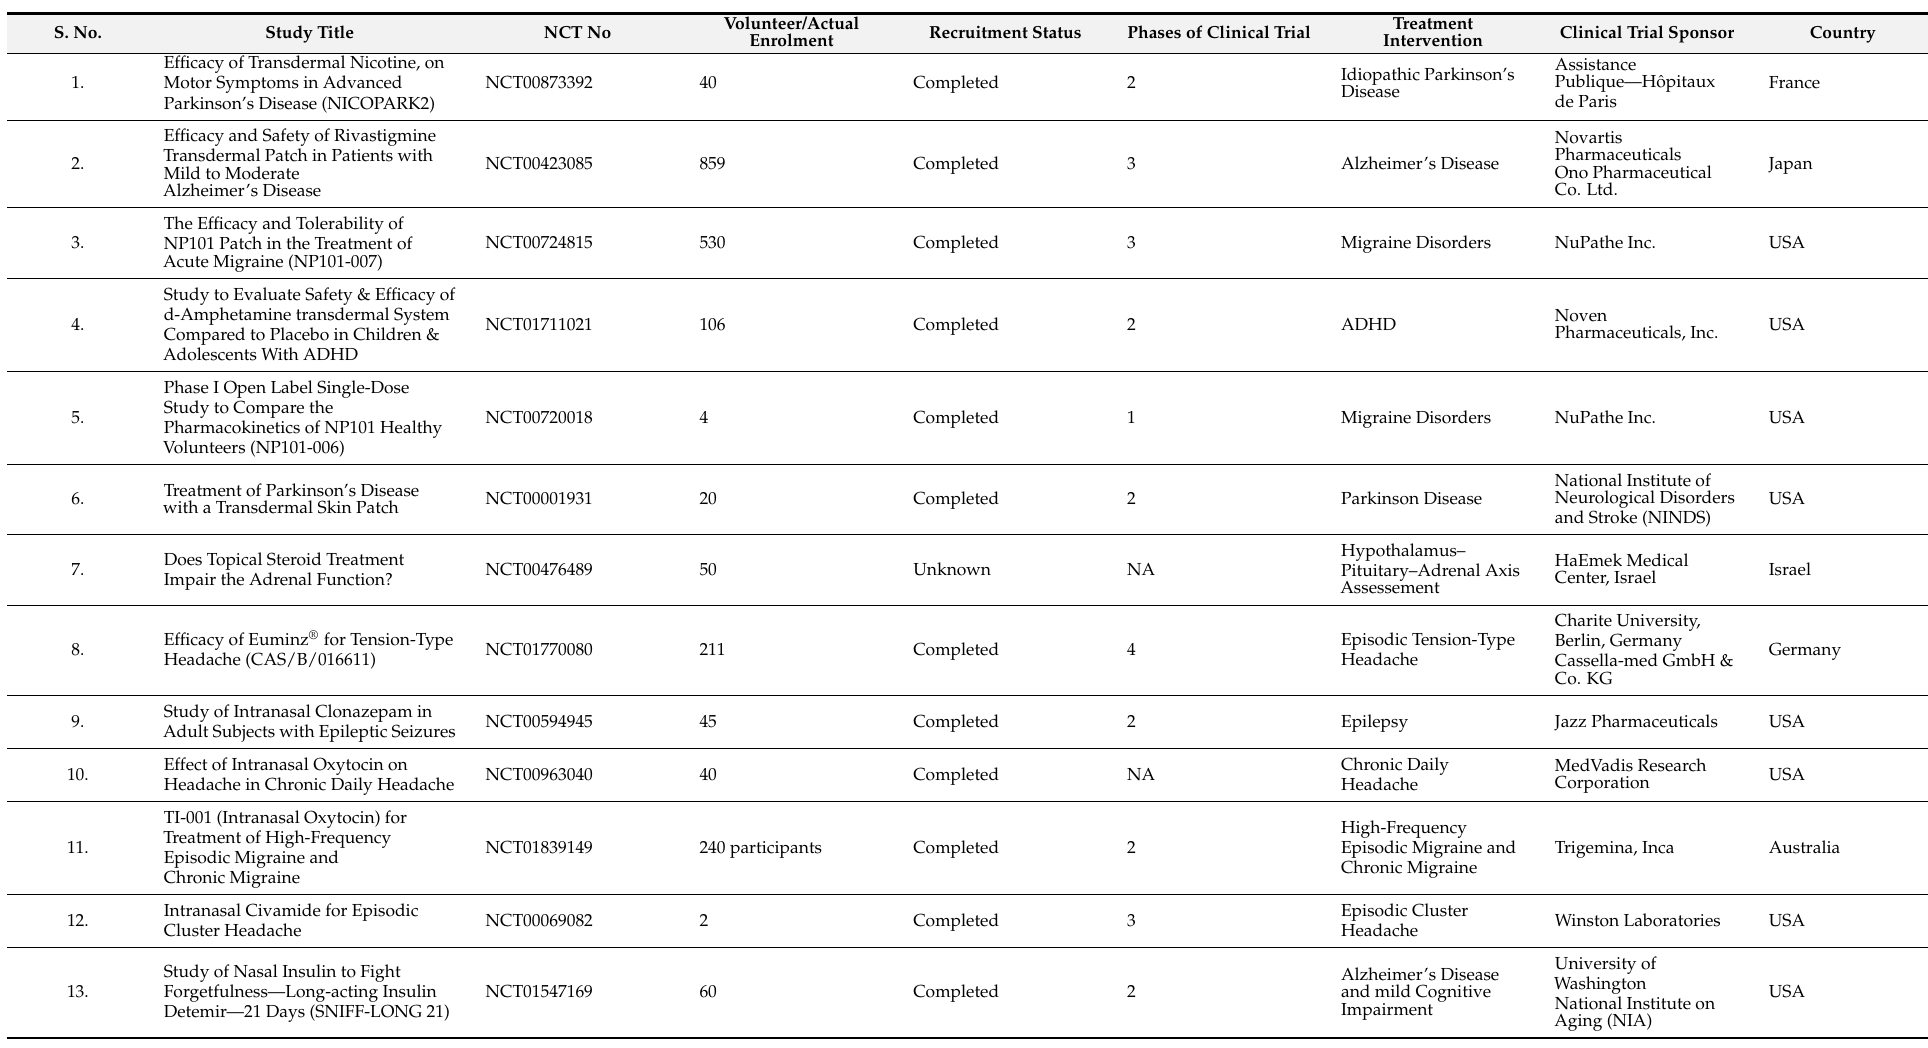
Table 3. Clinical trials involving pharmaceutical formulations administered through transdermal and intranasal routes, specifically for brain